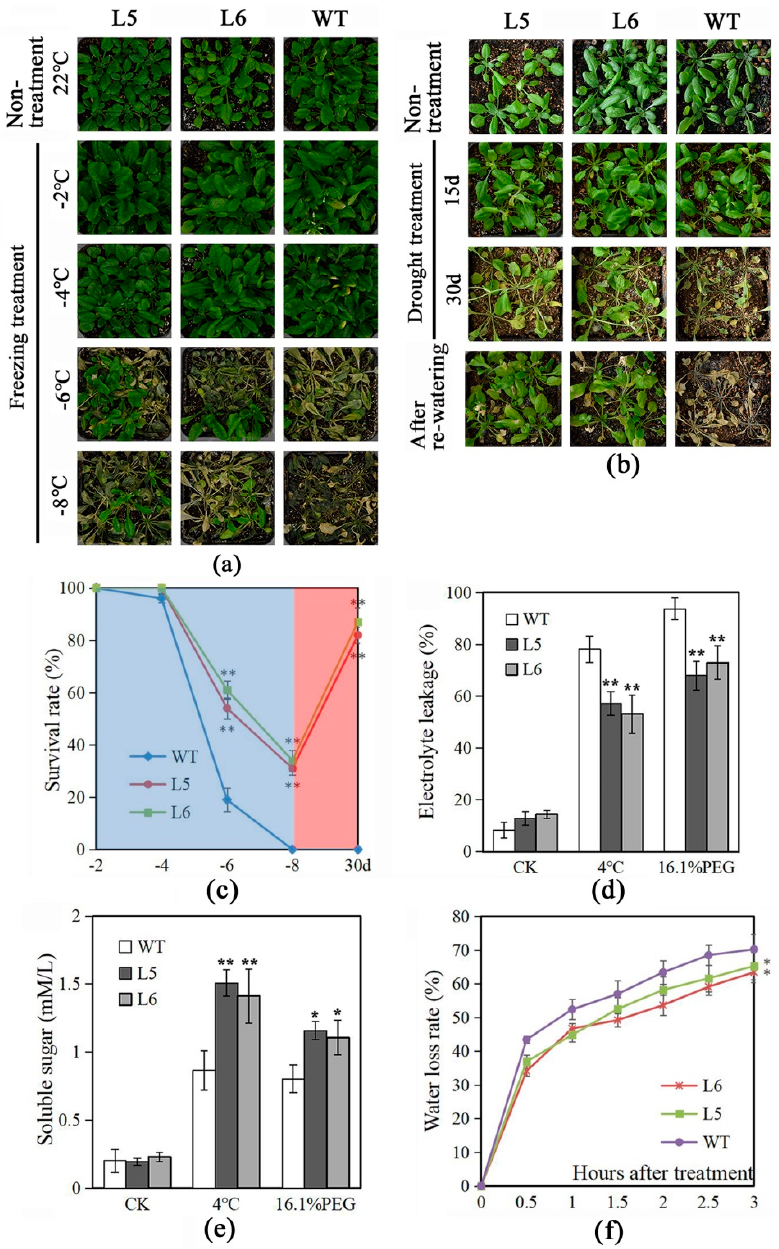
Figure 7. Overexpression of LlNAC2 in Arabidopsis enhances plant tolerance to cold and drought stresses. Performance of WT and LlNAC2 transgenic plants after freezing ( a ) and drought ( b ) treatments. ( c ) Survival rate of plants in ( a ) under freezing temperatures (blue region) and in ( b ) after drought treatment for 30 days (red region). Relative electrolyte leakage ( d ) and soluble sugar content ( e ) in WT and LlNAC2 transgenic lines after 4 °C and 16.1% PEG6000 ( − 0.5 MPa) treatment for 3 h. ( f ) Water loss rate of leaves from WT and LlNAC2 transgenic plants. Three biological replications were performed, each replication contains 30 plants. The bars show the SD. Asterisks indicate a significant difference 0.01 < * p < 0.05 and ** p < 0.01 compared with the corresponding controls. 2.8. Overexpression of LlNAC2 in Arabidopsis Increases Seed Sensitivity to ABA and Tolerance to NaCl